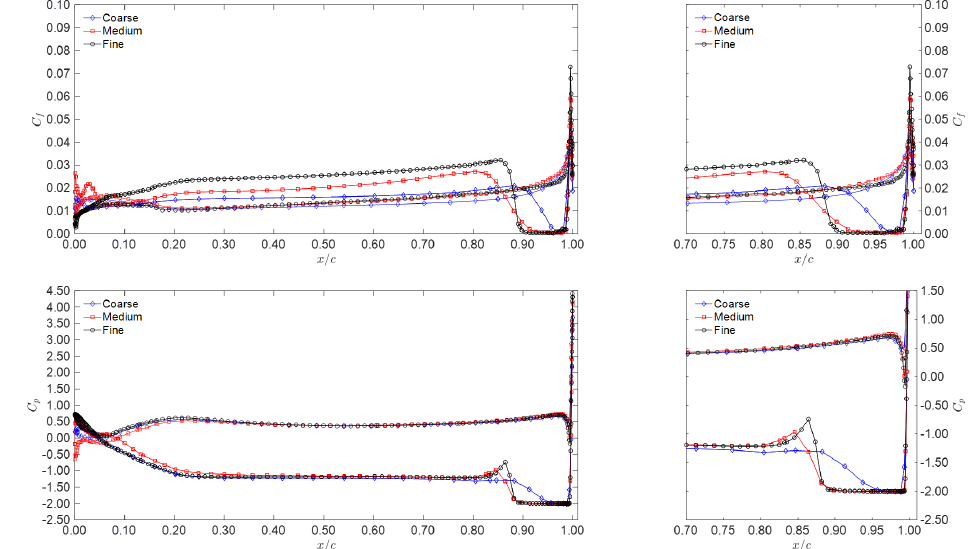
Figure 16. Comparison of skin-friction and pressure coefficient distributions at the radius r / R = 0.7 on the blades. PPTC Case 1 conditions in full scale. The results are from the three grid densities. The TE is at x / c = 0 and the LE at x / c =